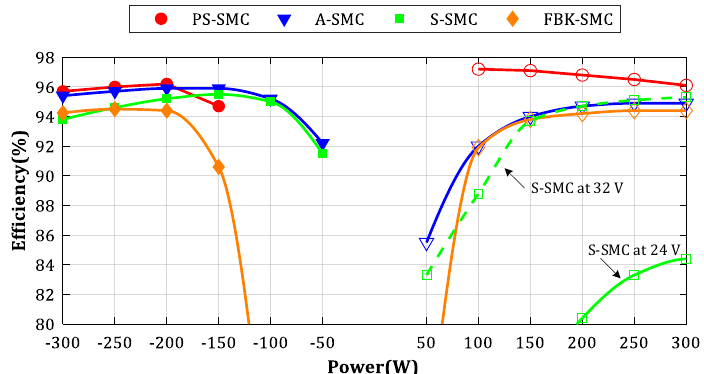
Figure 9. Measured efficiencies in different operating modes at U CS = 24 V (unless otherwise specified); negative power values denote buck mode, positive-boost mode.